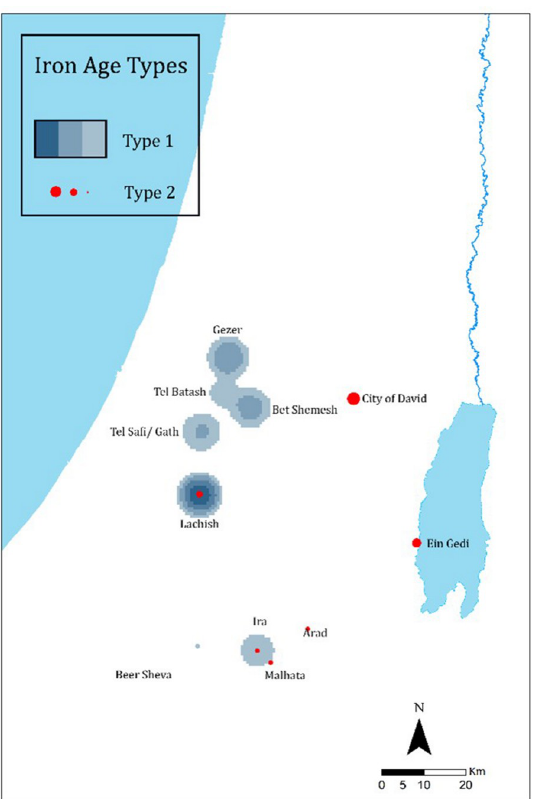
Fig 11. Density maps with ARCMAP showcasing the distribution of OSJ (Type 1) and Rosetta jars (Type 2).